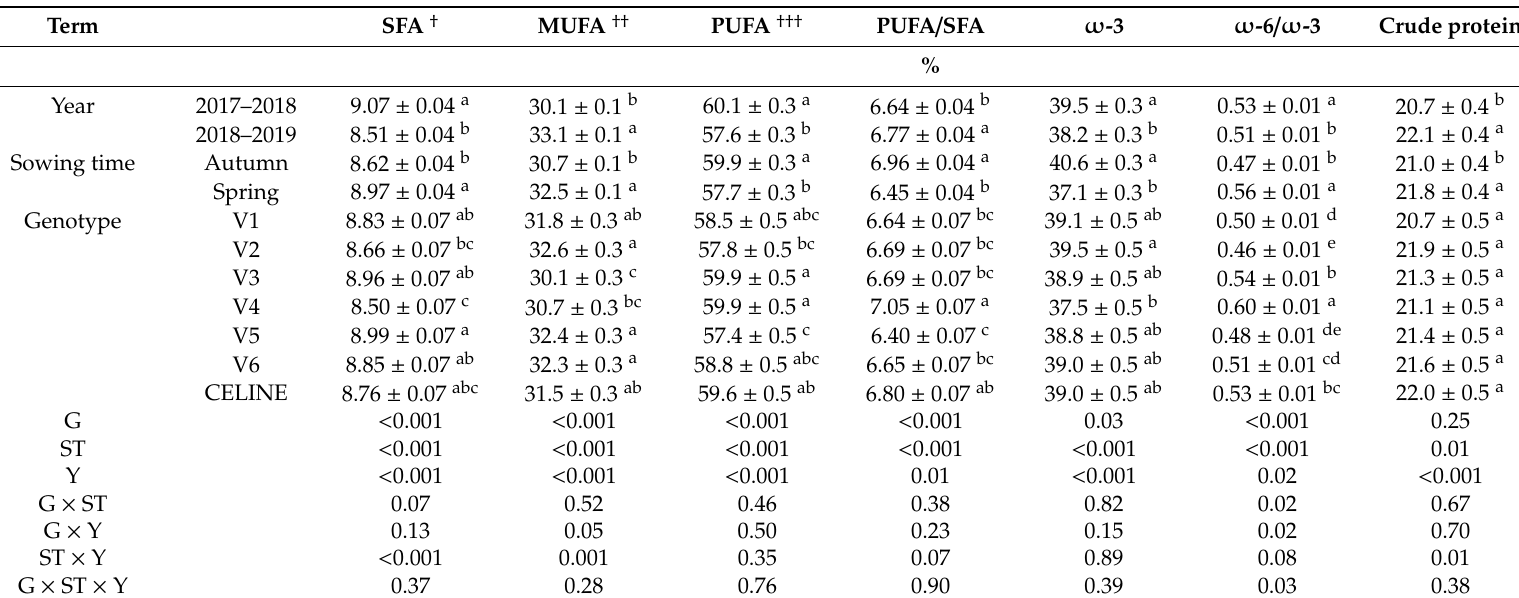
Table 6. Characteristics of camelina seed oil and protein content as a ff ected by genotype, sowing time, and year. Term